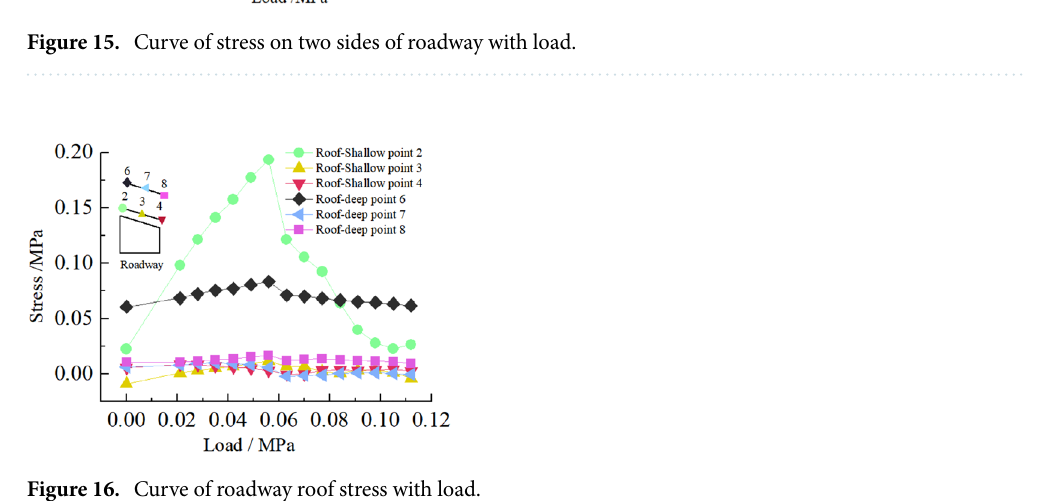
Figure 16. Curve of roadway roof stress with